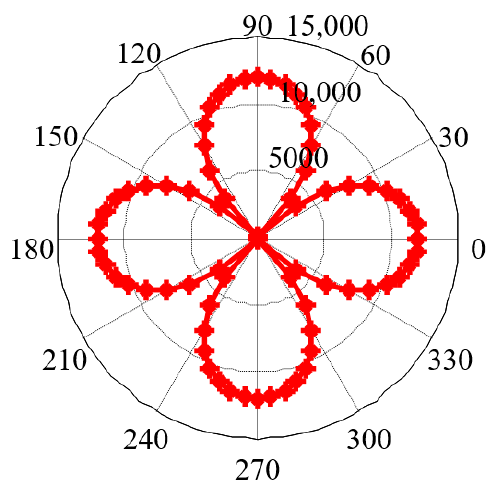
Figure 5. Simulation results of MCE ( g 1 ).